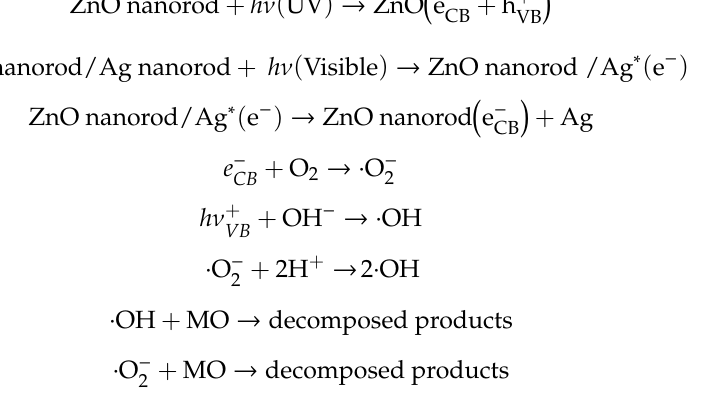
Figure S1: (a) Photocatalytic reactor system and (b) emission spectra of the 300 W OSRAM Ultravitalux lamp, Figure S2: SEM images of the cross section NRs films prepared under di ff erent conditions of seed deposition: (a) ZnO, (b) ZnO:N (1:1), (c) ZnO:N (1:3) and (d) ZnO:N (1:4), Figure S3: ( α .h ν ) 2 vs. h ν plots derived from transmittance spectra for ZnO for undoped ZnO and ZnO:N NRs films. Inset shows the extrapolation exclusively for the ZnO:N NRs films, Figure S4: Typical elemental analysis spectrums of ZnO NRs films (a) and ZnO:N NRs films (b), Figure S5: Backscattered electron micrograph of sample ZnO:N